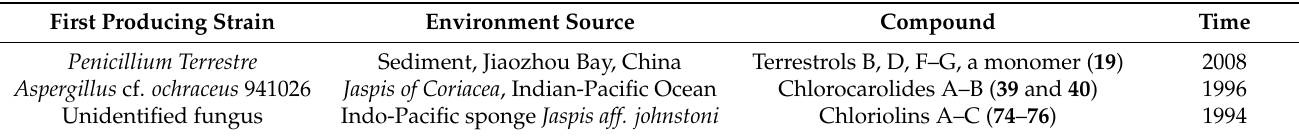
Figure 6. Numbers of new halogenated compounds reported annually from 1994–2019. Table 1. The initial research on antimicrobial active compounds from fungi.